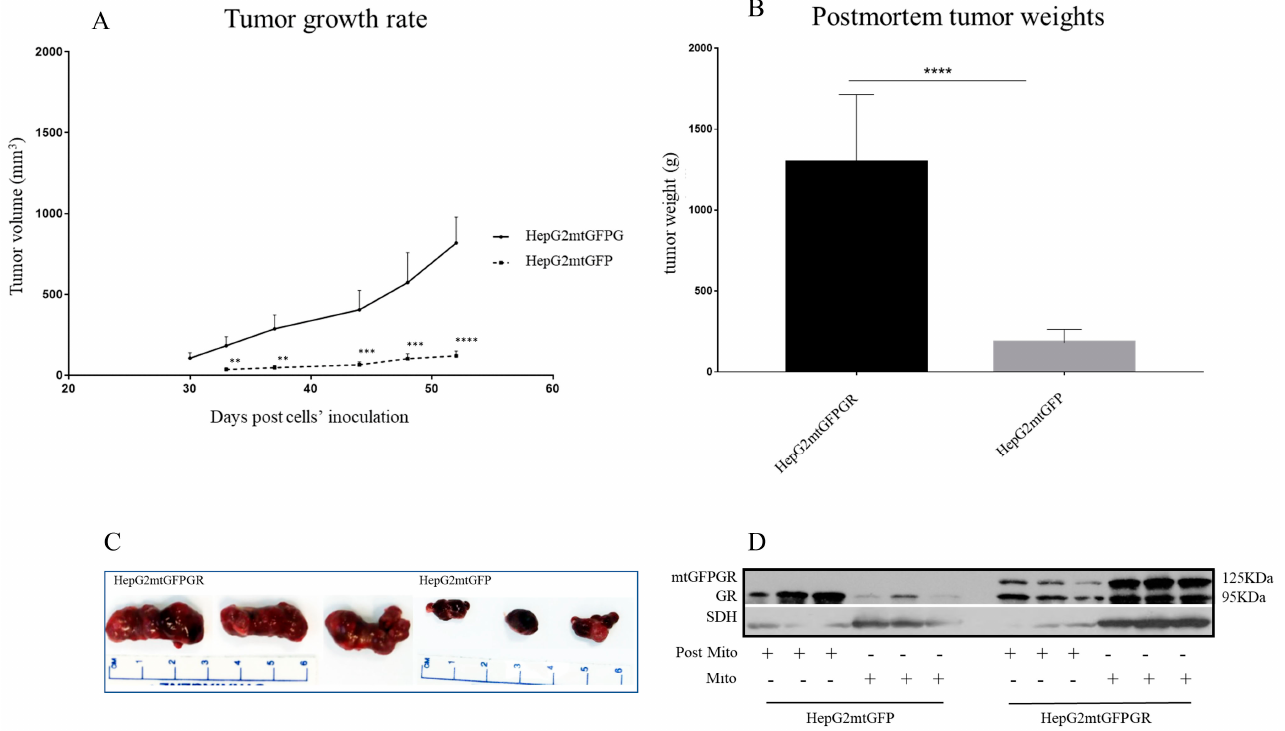
Figure 2. mtGR-induced increase in tumor progression in NSG mice inoculated with 1 × 10 5 cells (HepG2mtGFP, HepG2mtGFPGR). ( A ) The growth rates of the tumors in NOD/SCID mice and ( B ) postmortem weights of the tumors excised from the mice upon termination of the experiment. Each point shows the mean ± SD ( n = 10, 5 mice per group), ** p < 0.01, *** p < 0.001, **** p < 0.0001, compared to the HepG2mtGFP group. ( C ) Representative images of tumors from the two groups. ( D ) Western blot analysis of mtGR expression in Post-Mitochondrial (Post-Mito) and Mitochondrial (Mito) extracts from three representative tumors from each group.